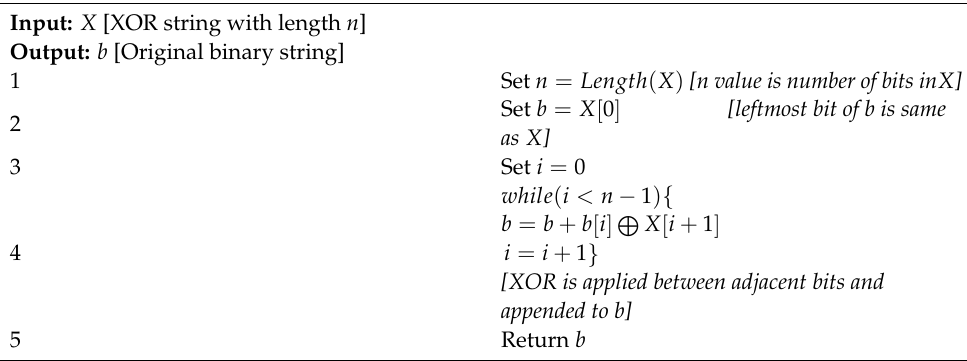
Algorithm 2: Obtaining original binary string from its XORed